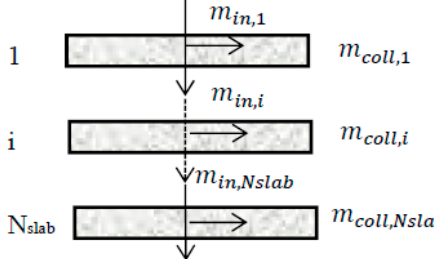
Figure 3. Scheme of the filter wall discretized into slabs.